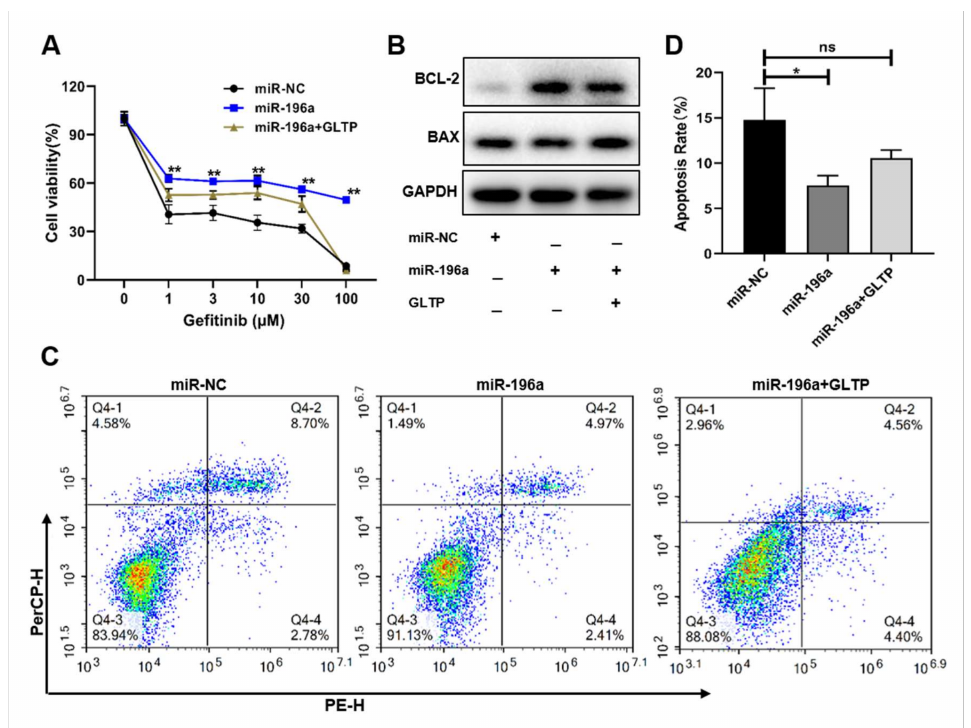
Figure 6. Forced expression of GLTP partly reversed miR-196a-inducing gefitinib resistance . PC-9 cells were transfected with GLTP overexpression lentivirus, then treated with miR-196a mimics. ( A ) Different concentrations of gefitinib were used to treat these cells for 48 h, CCK8 assay was performed for analyzing the cells viabilities. ( B ) The protein levels of apoptosis-related protein BCL-2 and BAX were measured in these cells by Western blotting. ( C ) The apoptosis levels were measured in the cells. ( D ) Quantitative analysis of apoptosis cell percentage was shown in ( C ). Data represent the mean ± S.D. of 3 independent experiments where * indicates significant difference at p < 0.05 ** indicates at p < 0.01, and ns denotes no